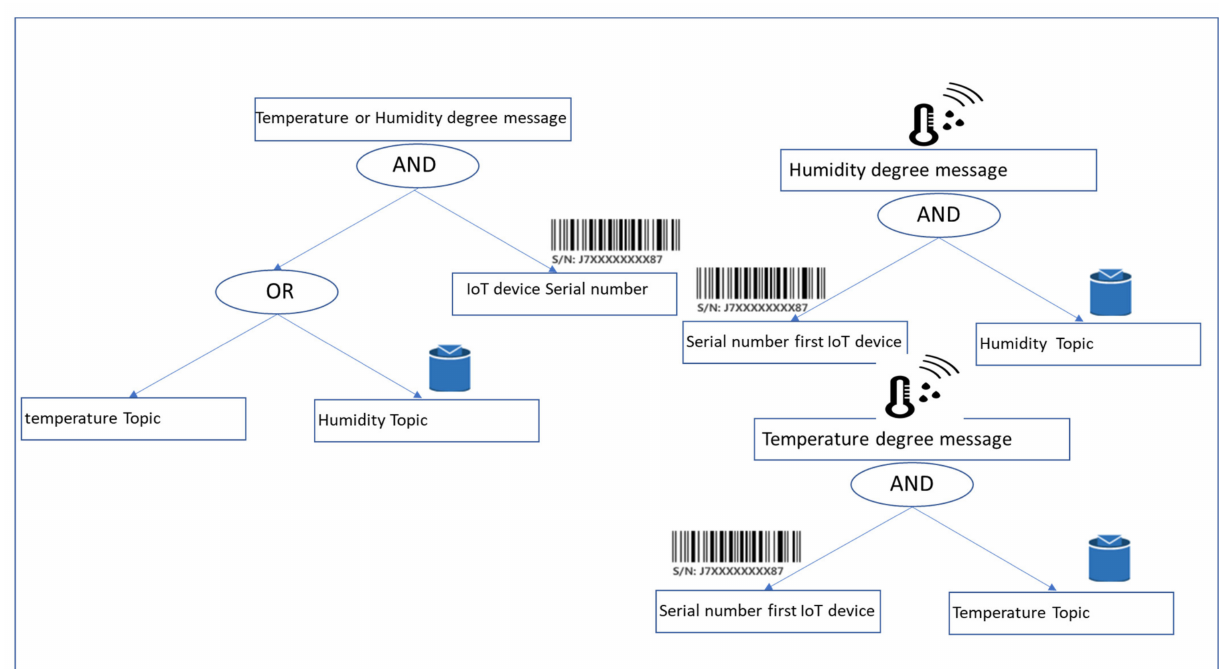
Figure 4. Access policy tree for the access control model for the IoT–Fog–Cloud architecture.